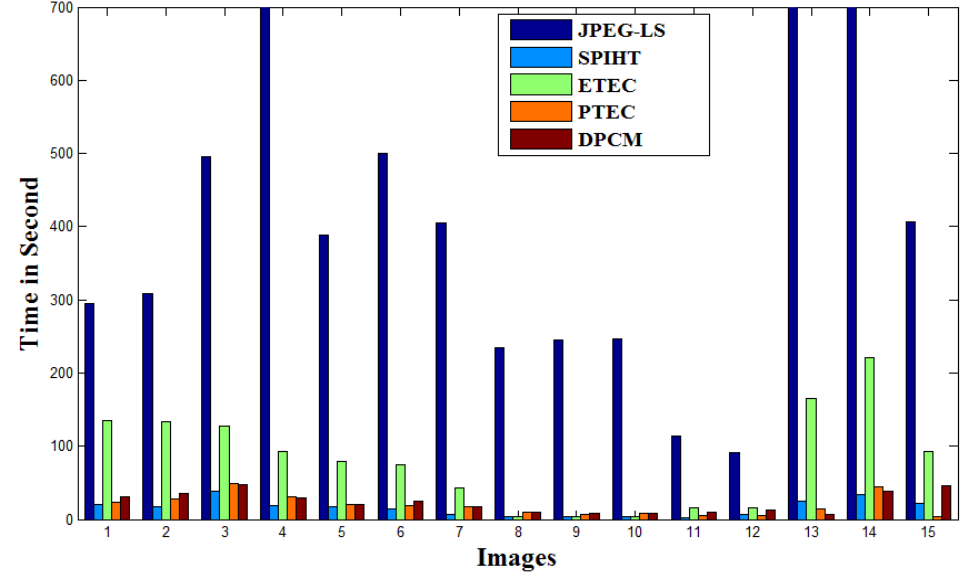
Figure 9. Comparison of computation time for pixelated images.